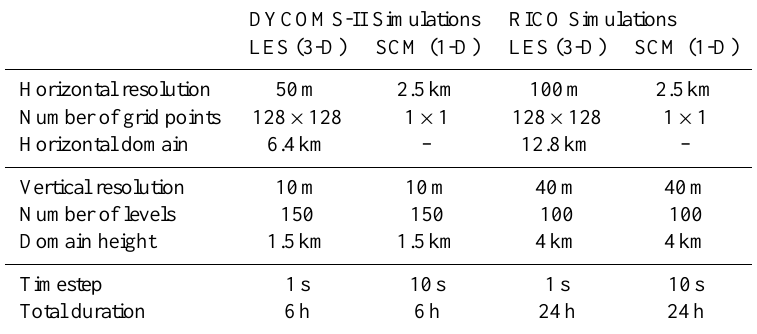
Table 1. Set-up for LES and SCM simulations of DYCOMS-II and RICO.